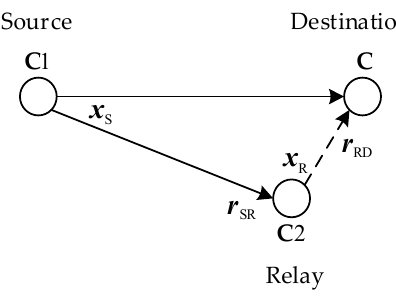
Figure 4 . Three-terminal coded-cooperation communication model. Figure 4. Three-terminal coded-cooperation communication